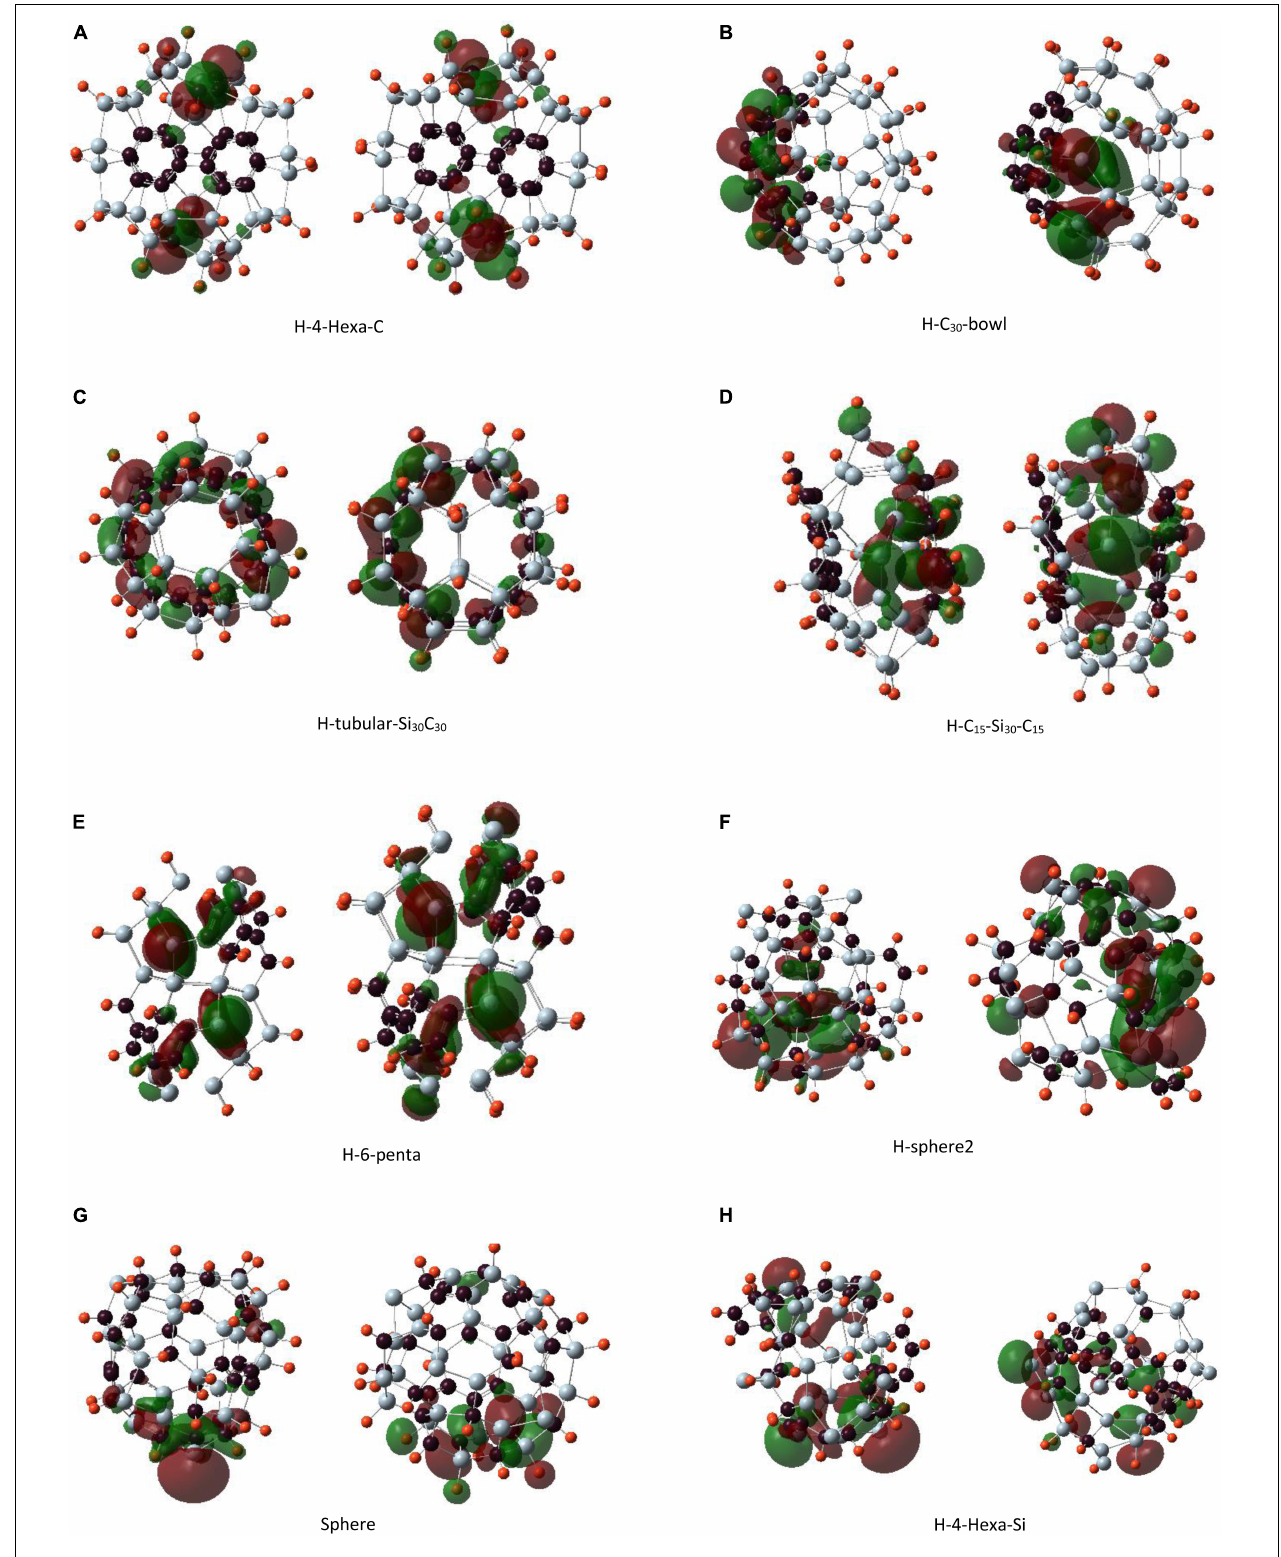
FIGURE 8 | The left panel shows the highest occupied molecular orbital and the right panel shows the lowest unoccupied molecular orbital plots for hydrogen-passivated Si 30 C 30 H 30 clusters. Structures are presented from panels (A–H) in order of their stability, most to least stable.